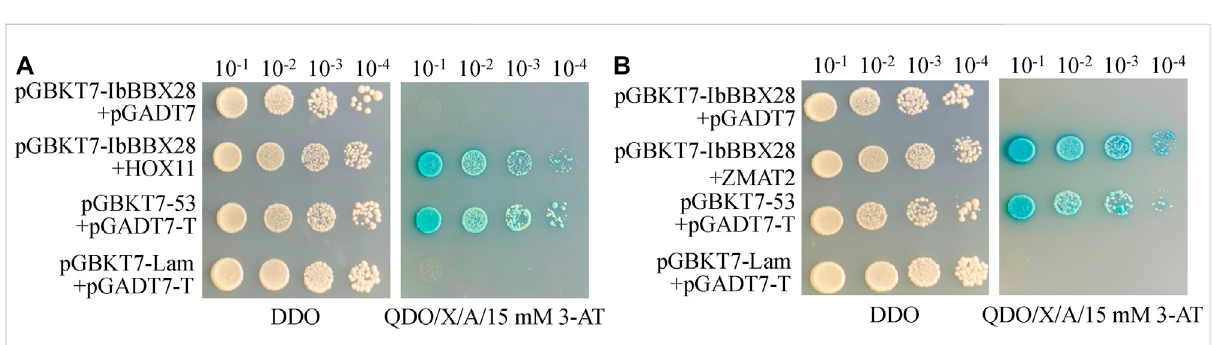
FIGURE 7 Plate validation of IbBBX28 and interacting proteins. (A) Plate validation of IbBBX28 and IbHOX11. (B) Plate validation of IbBBX28 and IbZMAT2.